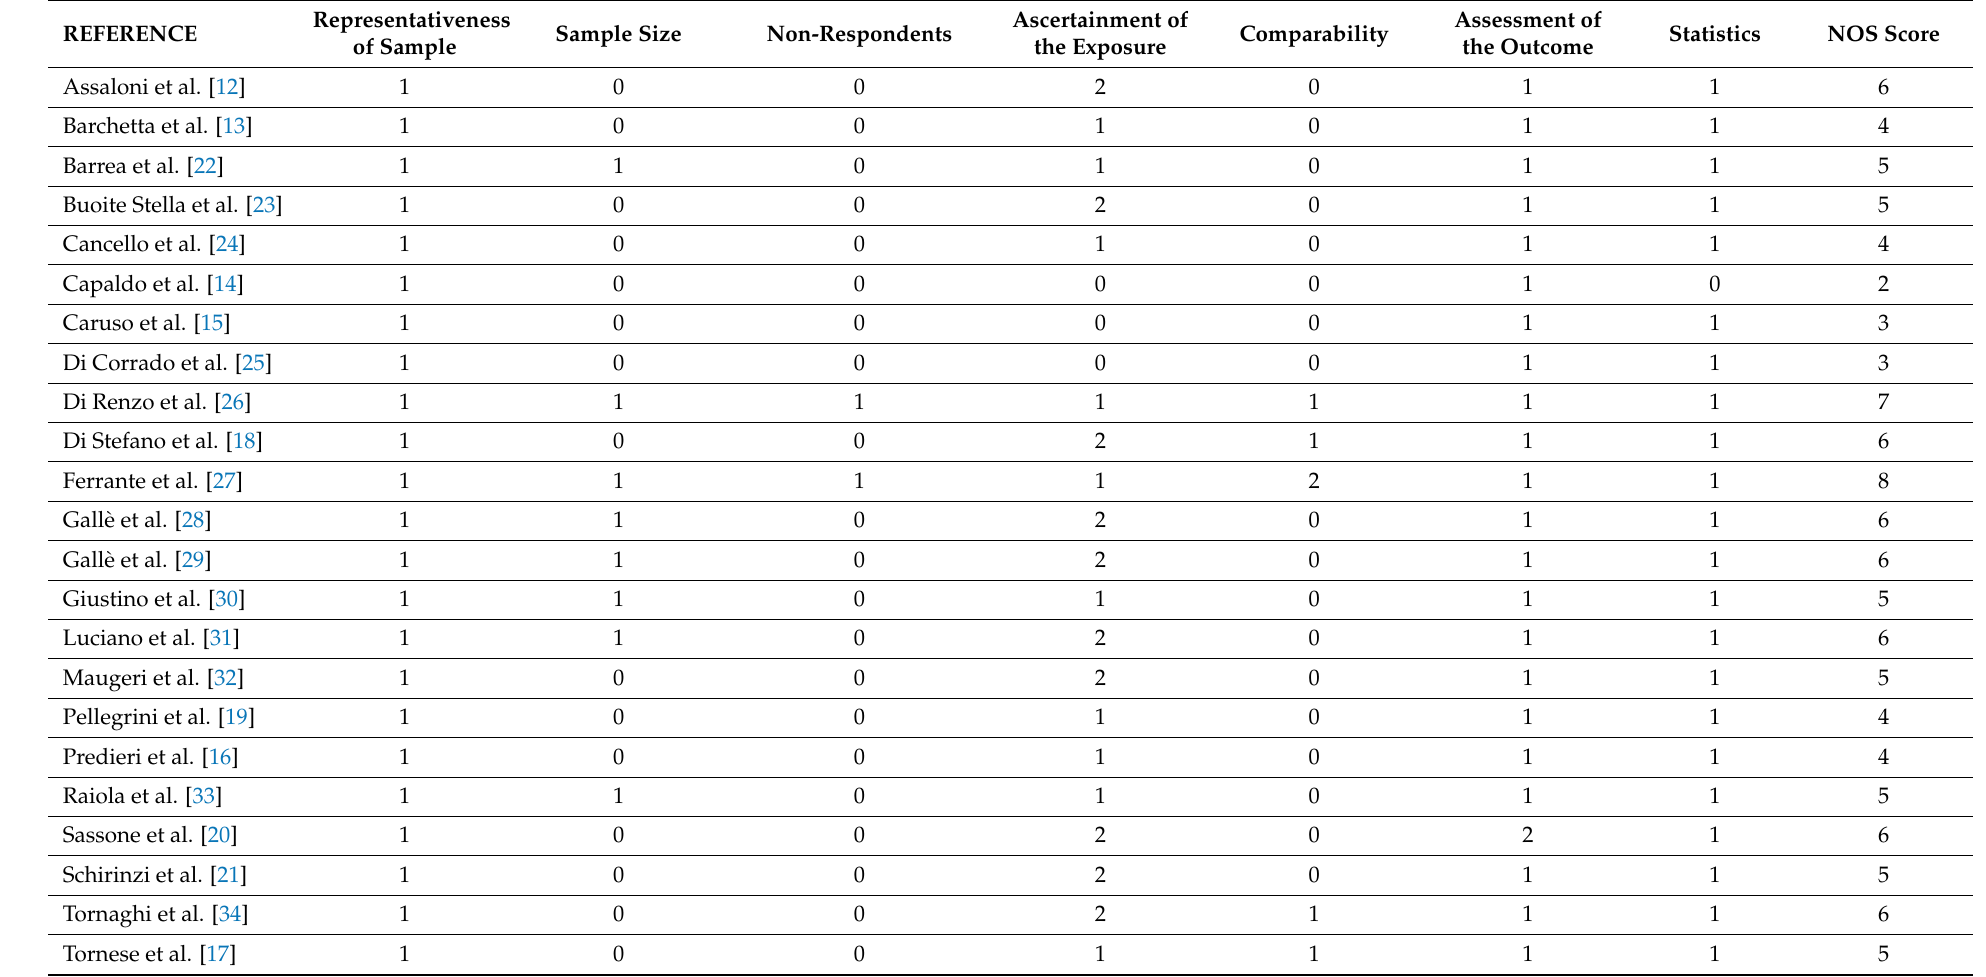
Table 2. NOS scores for all included studies (range: 0–10, with higher scores indicating better quality